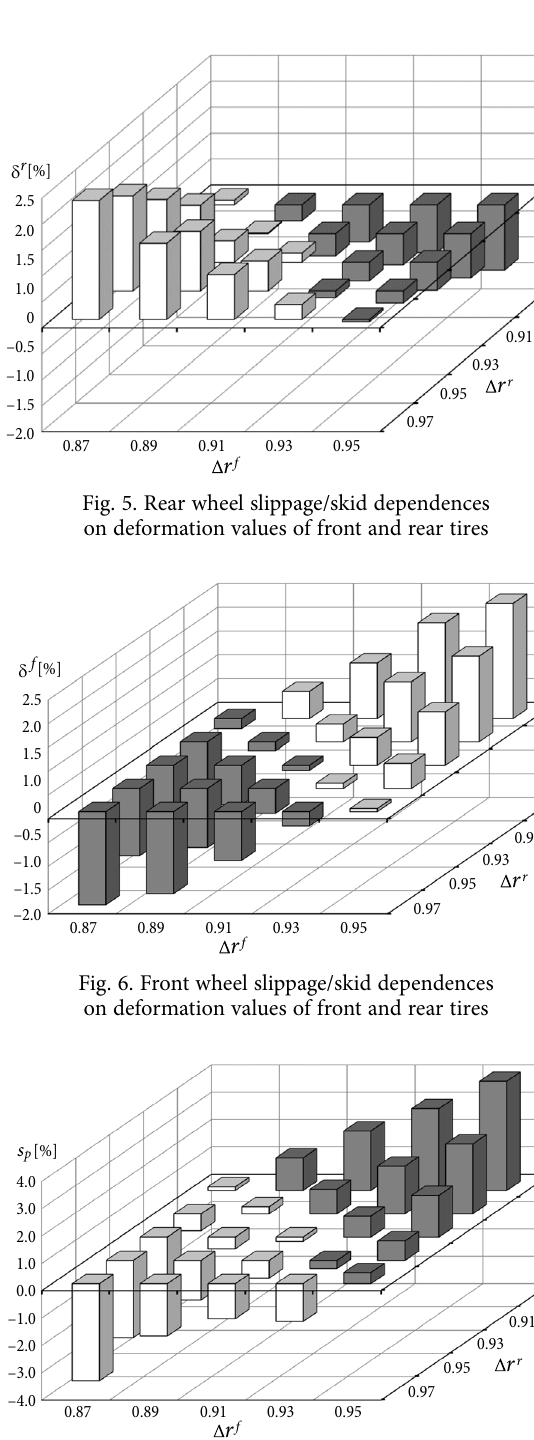
Fig. 7. Dependences of the lead of front driving wheels on deformation values of front and rear